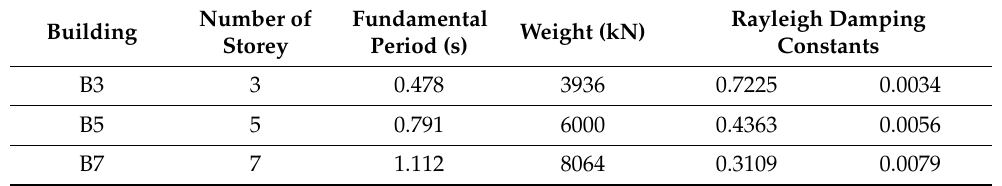
Table 3. Dynamic properties of the considered